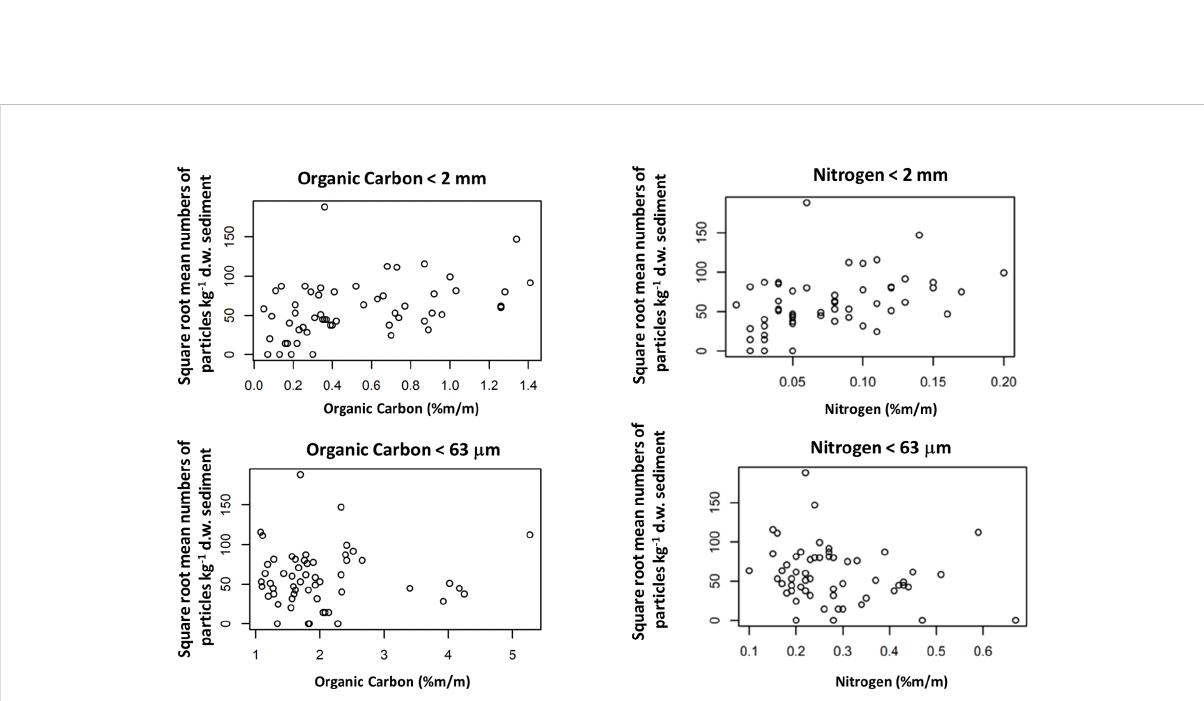
FIGURE 8 Plots of square root of the mean number of particles kg -1 d.w. sediment against Organic carbon and Nitrogen (%m/m) for < 63 m m and < 2 mm sediment size